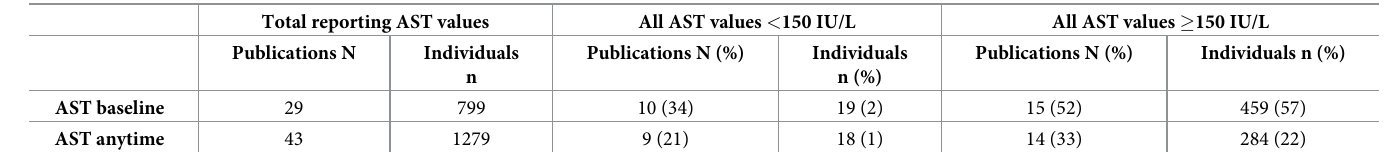
Table 6. AST ranges in papers reporting AST